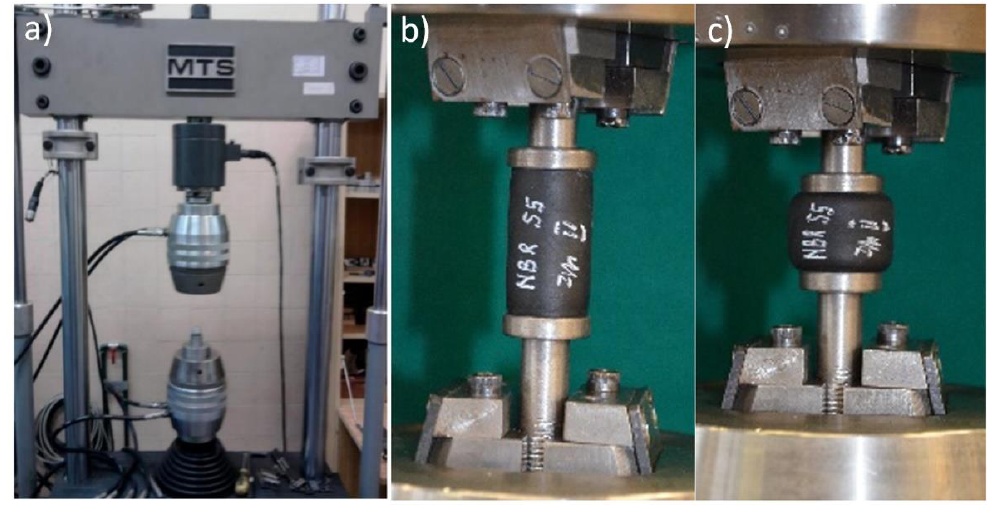
Figure 4. From the left: ( a )—view of MTS 810.12 tensile machine, ( b )—NBR 55 absorber during the initial phase o tests, ( c )—NBR 55 absorber under static compresion of 20 mm.